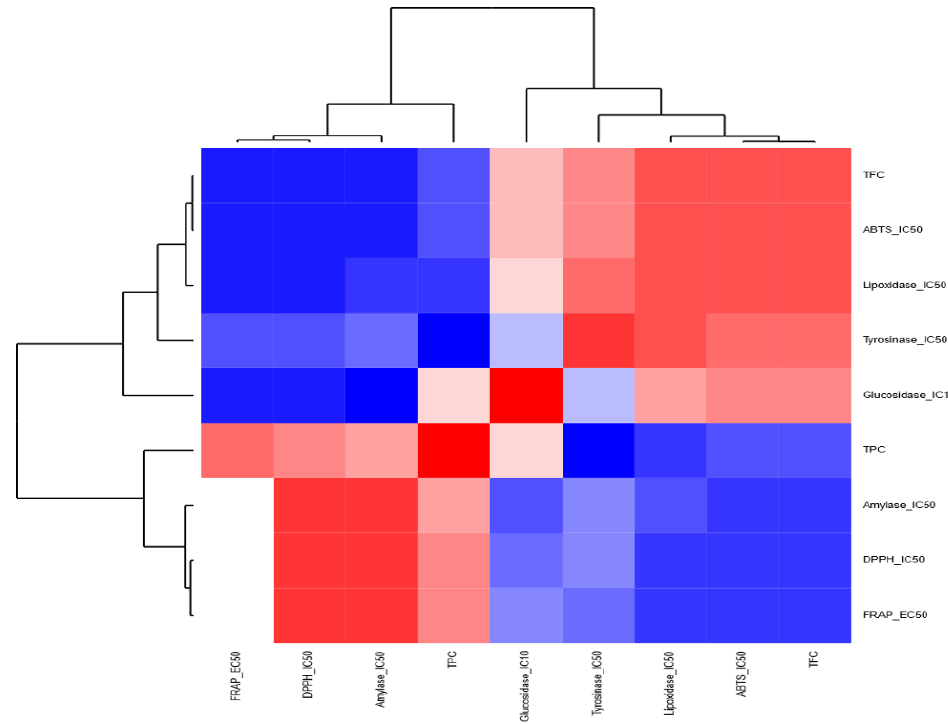
Figure 8. Heatmap highlighting the relationships among the chemical screenings within the meth- anolic extract of husk.